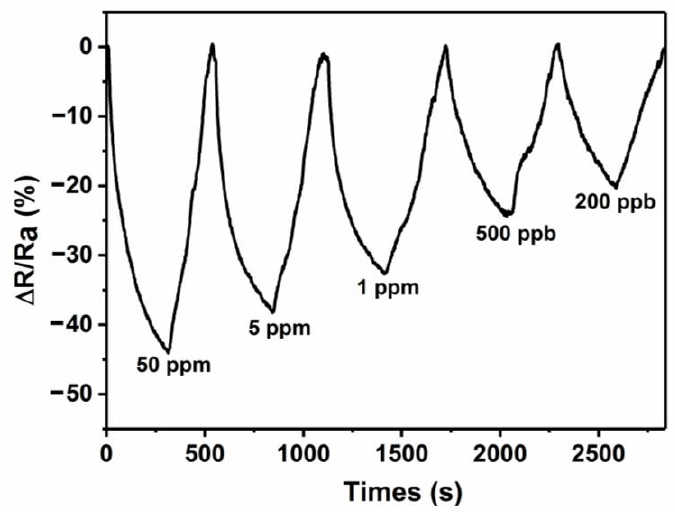
Figure 10. The gas response curves of E 0 -based gas sensor under different NO 2 concentrations.